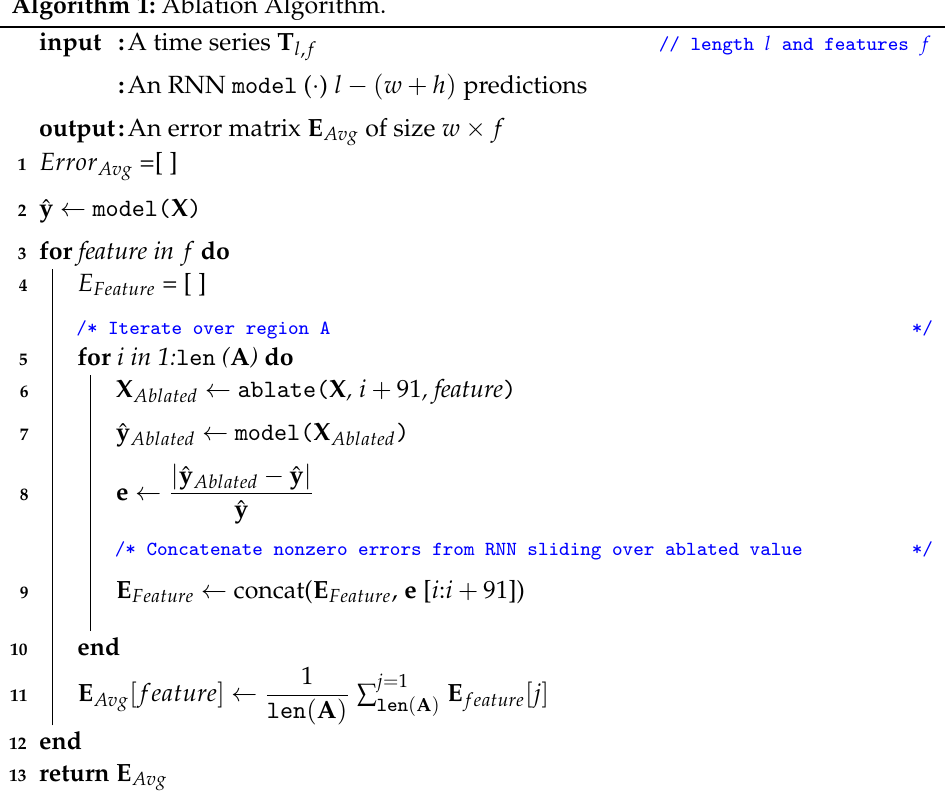
Algorithm 1: Ablation